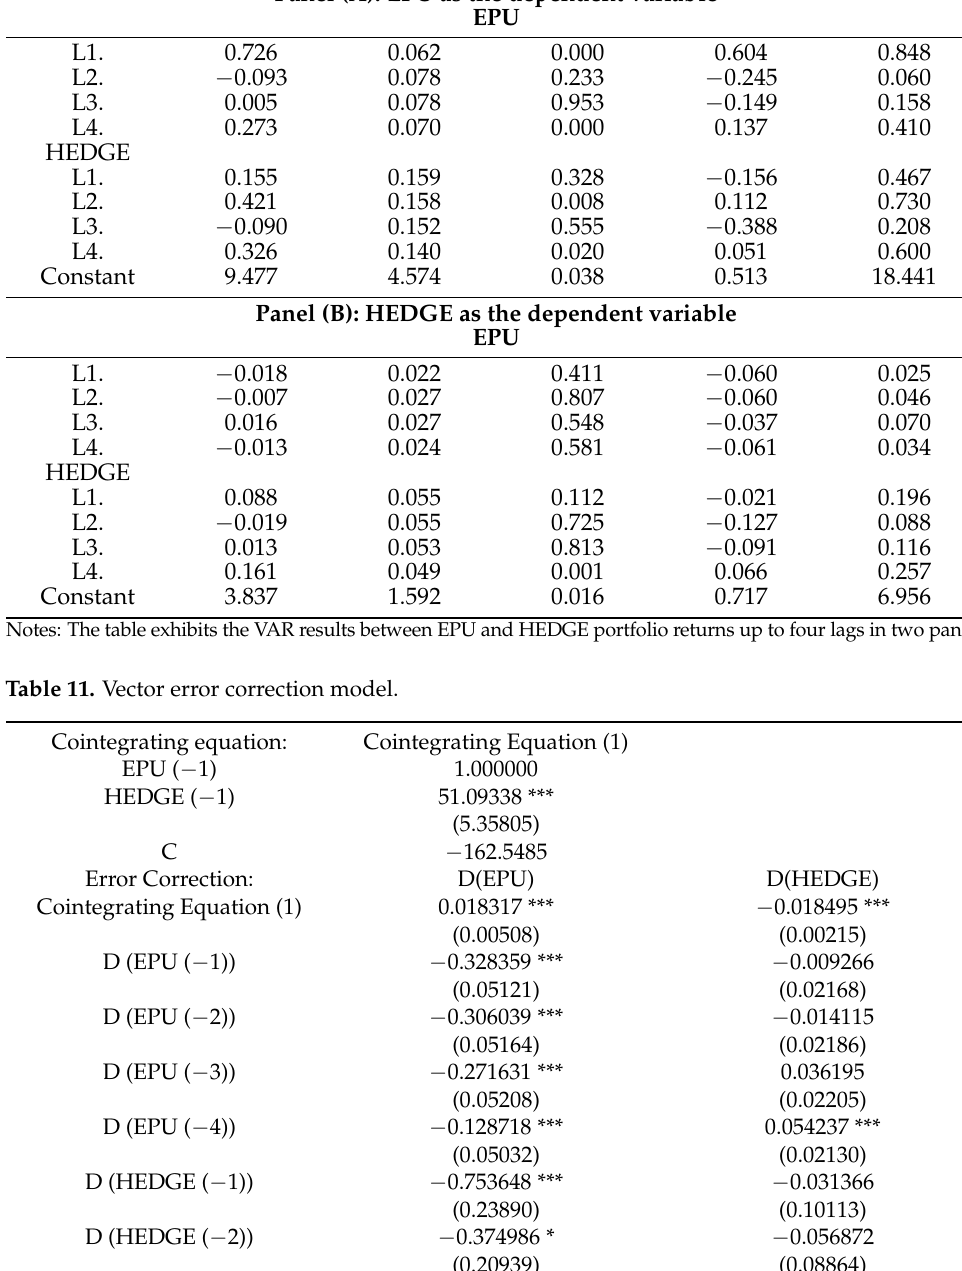
Table 10. Vector autoregression results. Coef. Std. Err. 95% Conf.